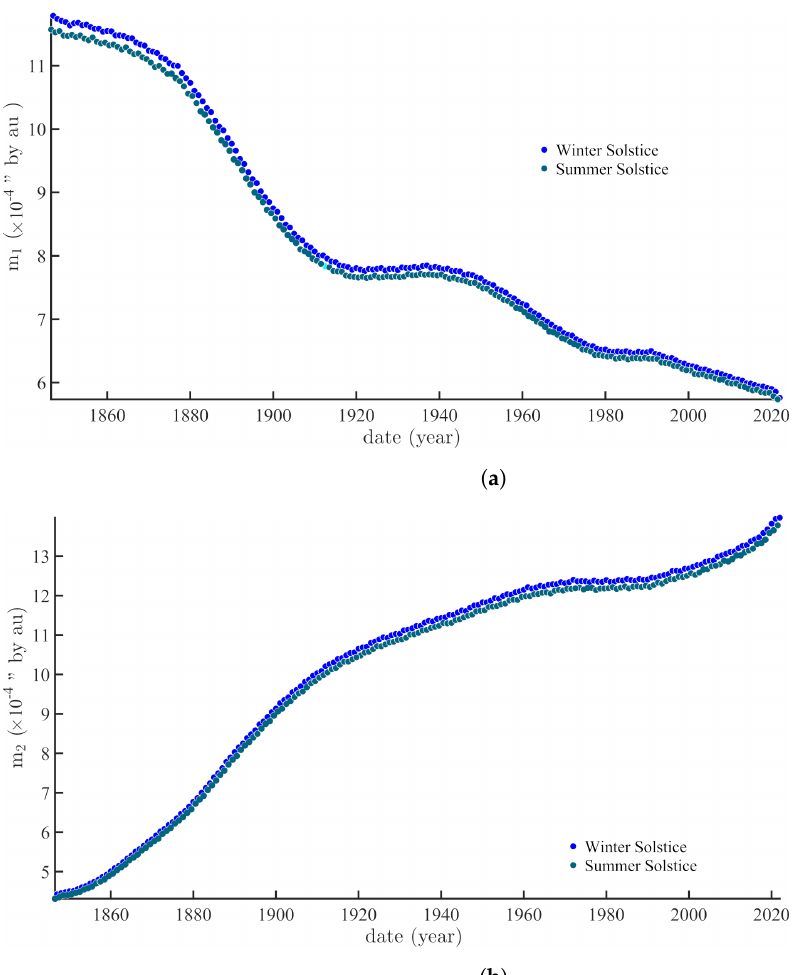
Figure 7. Time evolution of winter and summer solstices. ( a ) Time evolution of winter and summer solstices for component m ∗ . ( b ) Time evolution of winter and summer solstices for component m ∗ 1